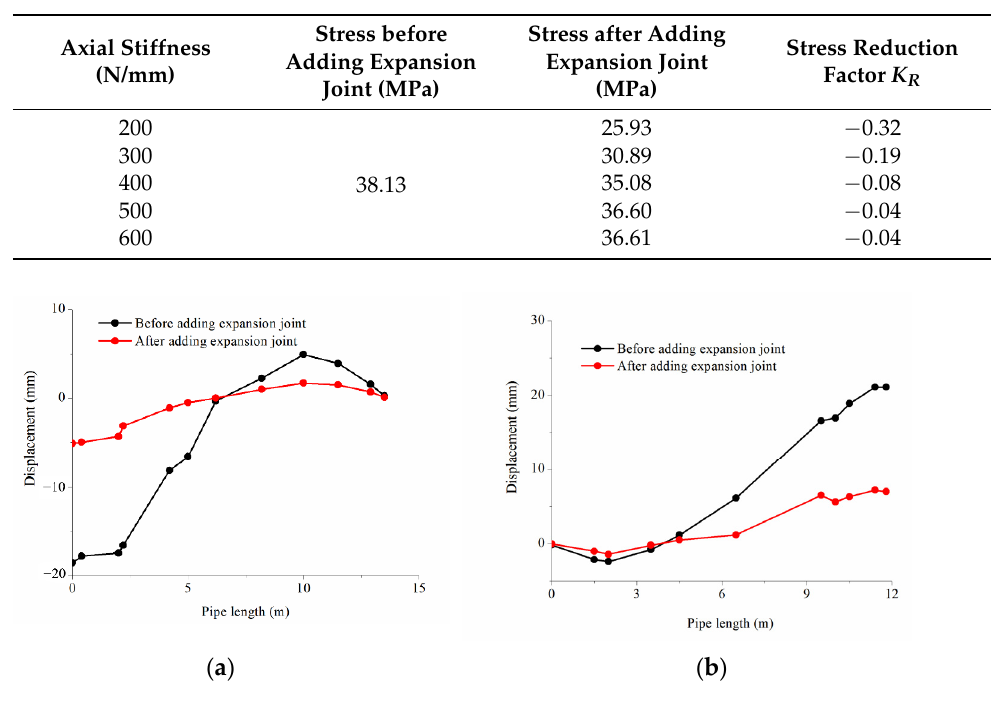
Table 9. The stresses of RC1-B4 after adding different kinds of expansion joints.